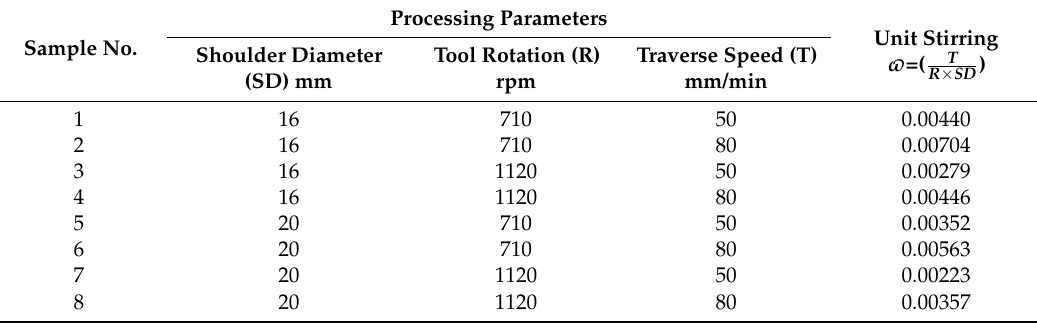
Table 2. Experiment plan, processing parameters and derived